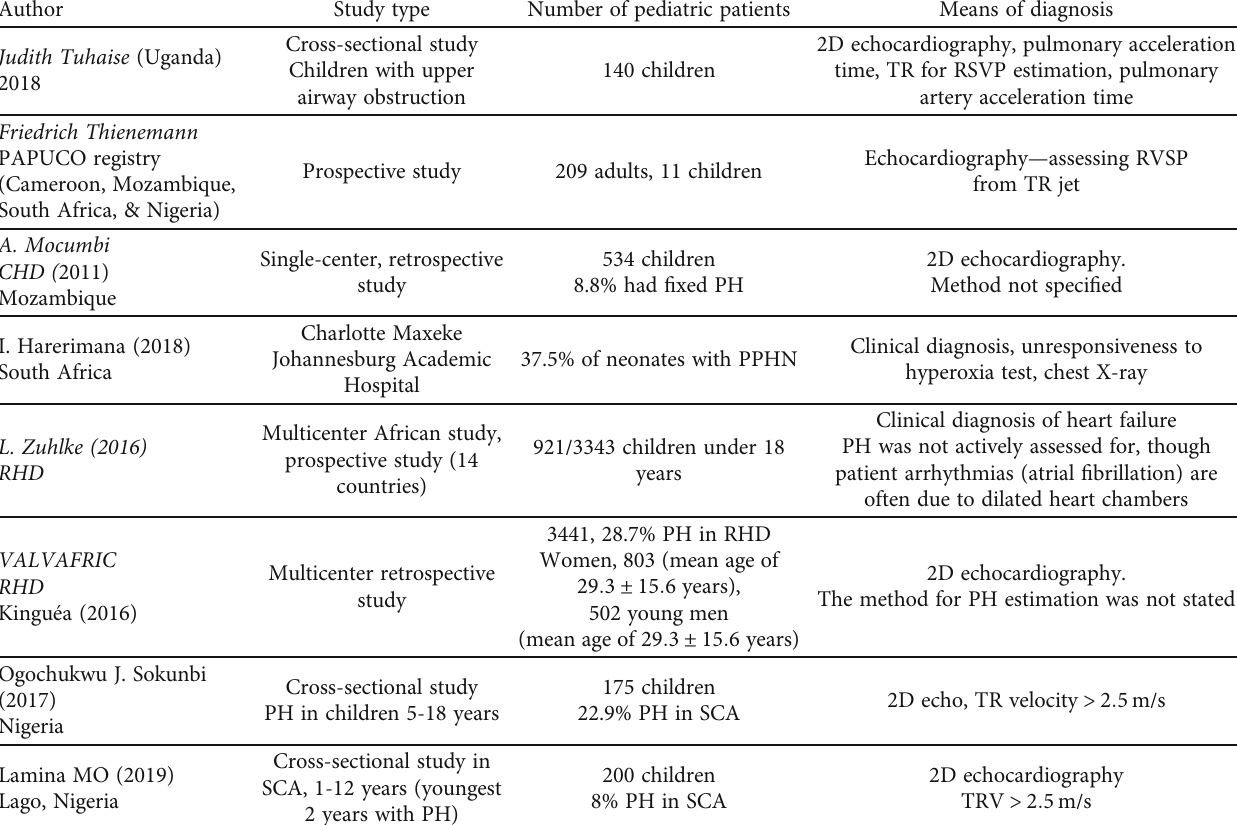
Table 1: PAH and common disease-speci fi c studies done in the pediatric population in Africa.